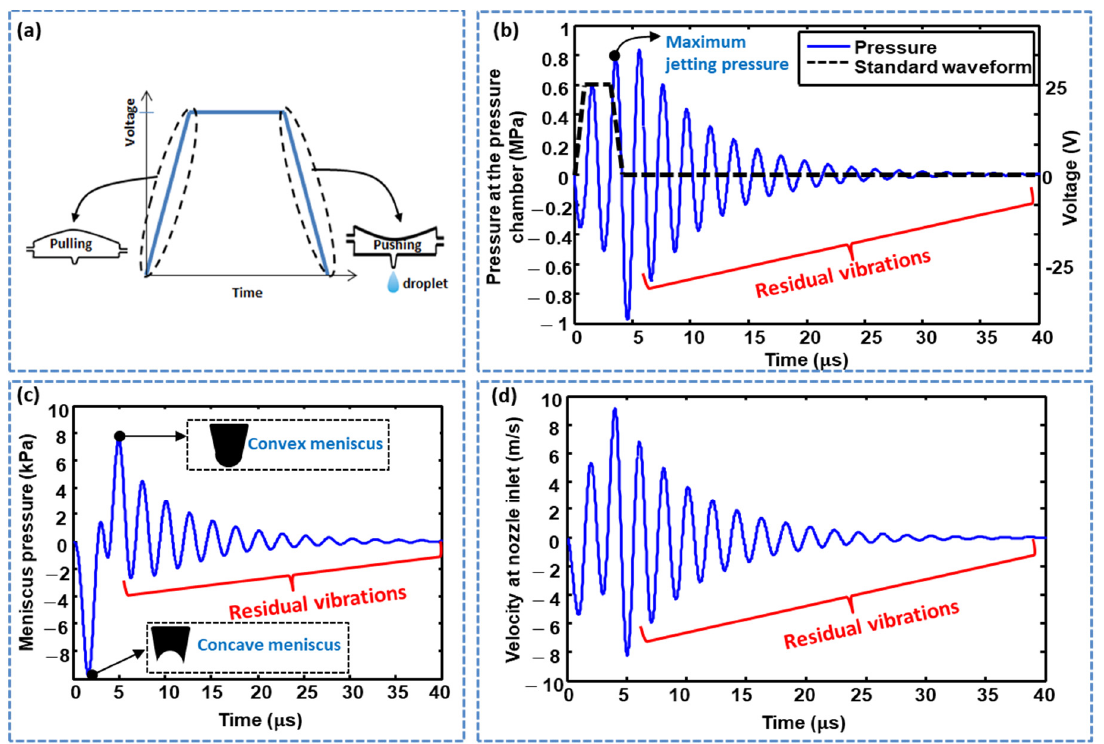
Figure 6. ( a ) Actuating mechanism of a piezoelectric inkjet printhead; ( b ) pressure profile at the pressure chamber; ( c ) meniscus pressure profile; and ( d ) velocity profile at the nozzle inlet generated by the standard voltage waveform.